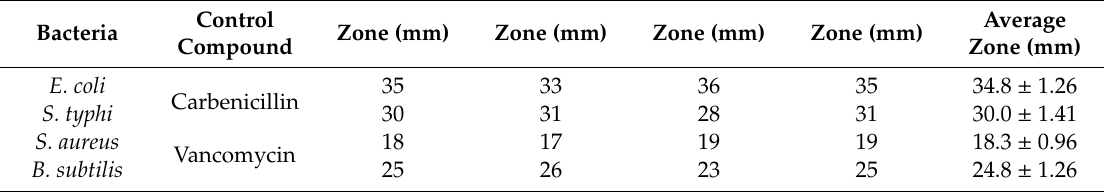
Table 1. Mean values of inhibitory zones generated by the control compound for Gram ( + ve) and Gram ( − ve) bacteria.